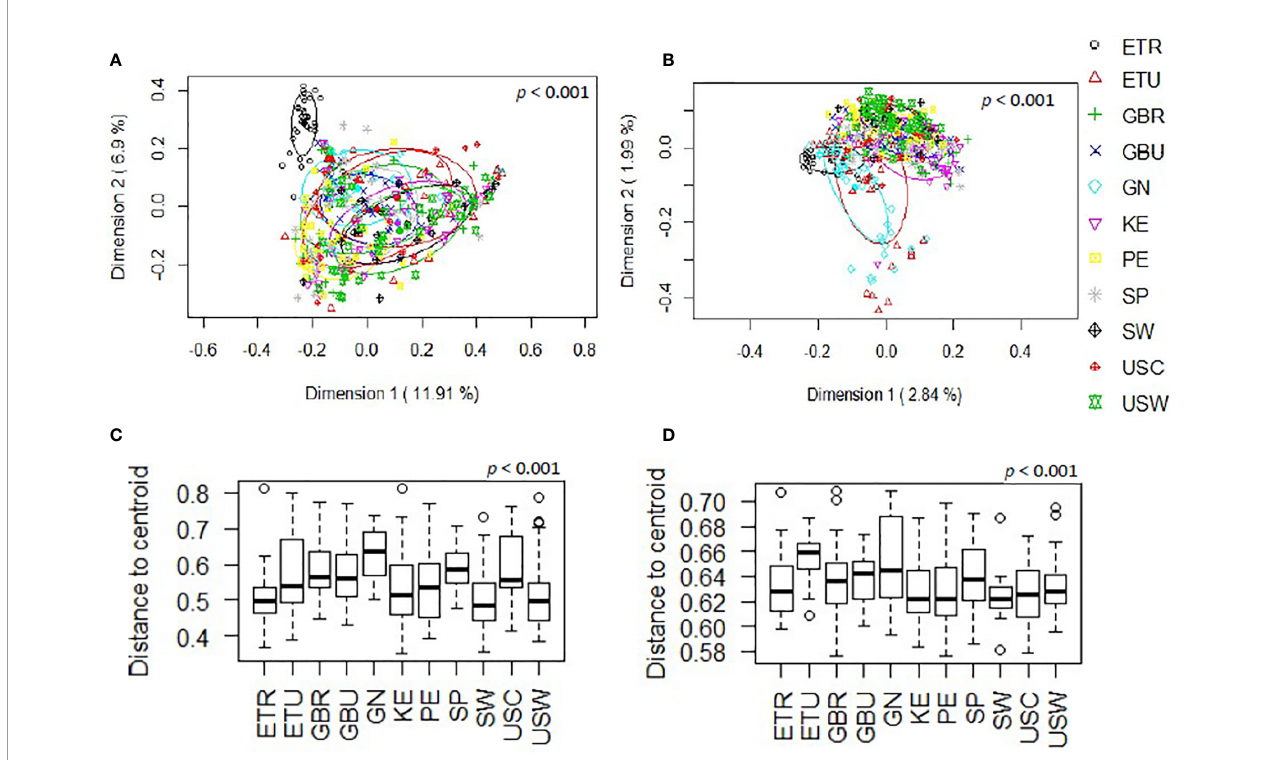
FIGURE 2 | Comparison, at the genus level, of the beta diversity of the different cohorts included in this work. (A) Principal coordinate analysis (PCoA) plots of bacterial pro fi les based on the Bray-Curtis similarity analysis (relative abundance). (B) Principal coordinate analysis (PCoA) plots of bacterial pro fi les at the genus level based on the Jaccard ’ s coef fi cient for binary data (presence or absence). The values on each axis label in graphs (A, B) represent the percentage of the total variance explained by that axis. The differences between groups of milk samples were analyzed using the PERMANOVA test with 999 permutations. (C) Comparison of the mean distances of samples to the centroids in the PCoA plots based on the Bray-Curtis dissimilarity index of each group. (D) Comparison of the mean distances of samples to the centroids in the PCoA plots based on the Jaccard ’ s coef fi cient of each